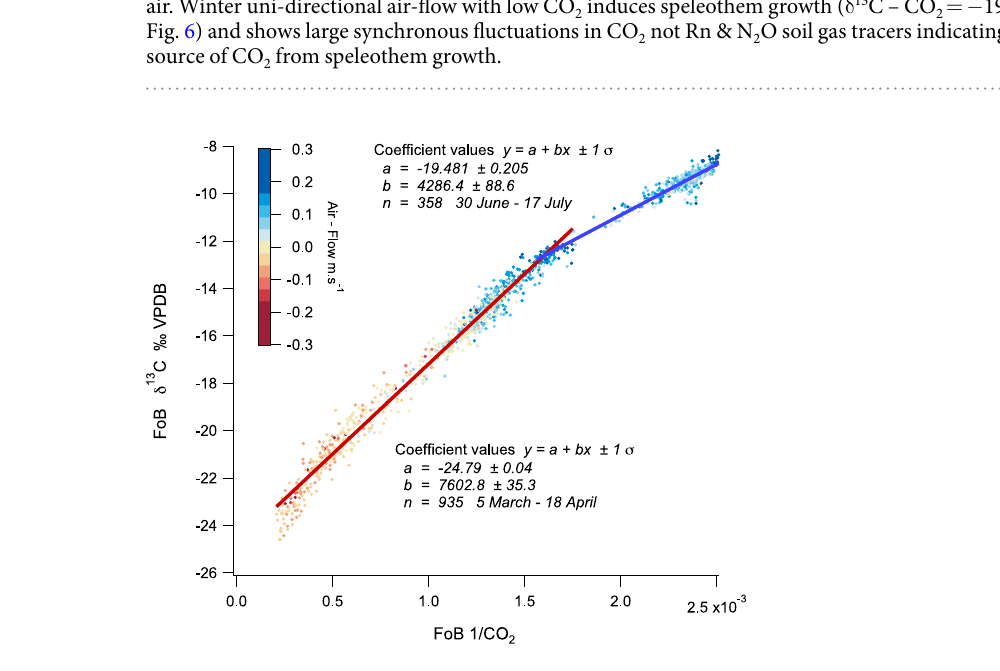
Figure 6. A Keeling plot of δ 13 C – CO 2 vs 1/CO 2 from Flitch of Bacon. for two time periods; autumn 5/3/15– 18/4/15, least squares line fit (red), n = 935 and winter 30/6/15–17/7/15, least squares line fit (blue), n = 358. Data points are colour coded to represent air-flow direction and velocity. The Keeling plot intercept provides the δ 13 C – CO 2 of the CO 2 source component mixing with air. The source of high CO 2 in LKB during autumnal (April) bi-directional airflow has δ 13 C – CO 2 = − 24.8‰ VPDB. The source of cave CO 2 during winter with near uni-directional airflow has δ 13 C – CO 2 = − 19.5‰ VPDB, representing speleothem growth CO 2 degassing within the Cave ( δ 13 C drip water − HCO 3 (aq) − 10.0‰ + fractionation 16 − HCO 3 (aq) - CO 2 (g) at 11 °C − 9.48‰ = − 19.5‰